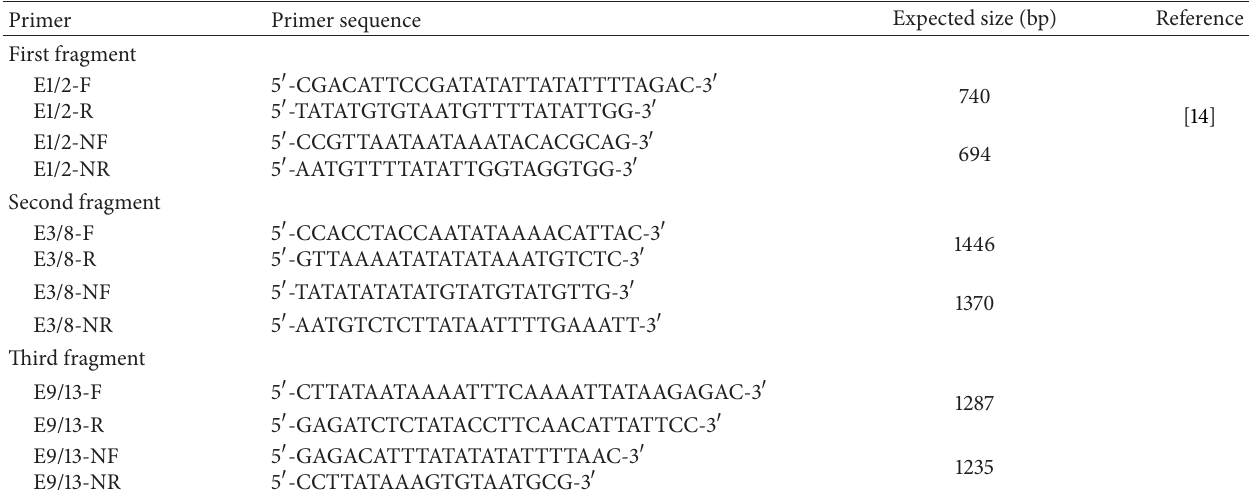
Table 1: Primers for pfcrt PCR